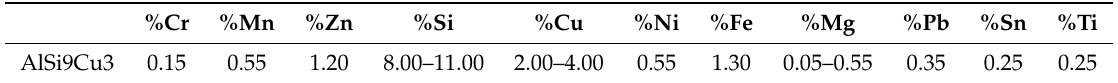
Table 2. Composition of the aluminium alloy